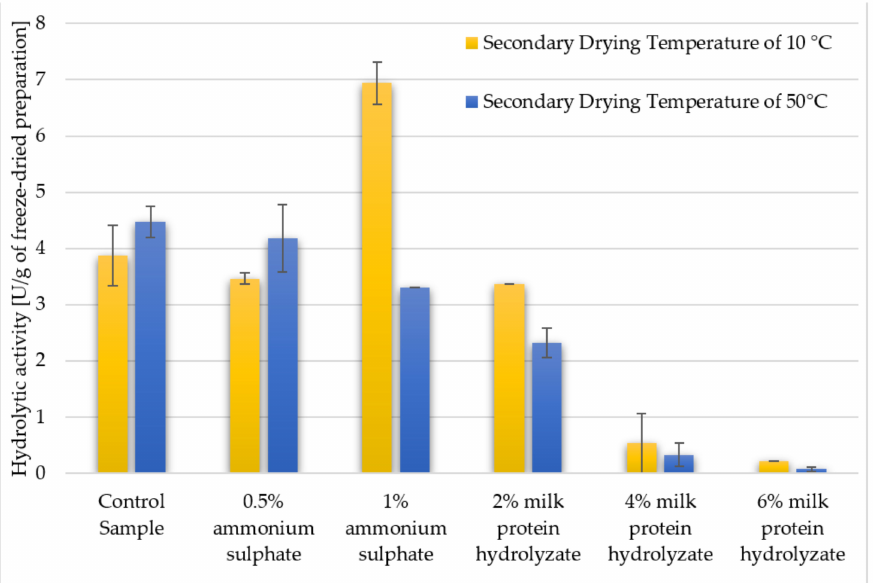
Figure 5. The effect of the applied cryoprotectant and the secondary drying temperature during the freeze-drying process on the hydrolytic activity of the lyophilized enzyme preparation (calculated per 1 g of the final preparation taking into account the presence of both the lyophilized supernatant and the addition of cryoprotectant). Experiments were performed in